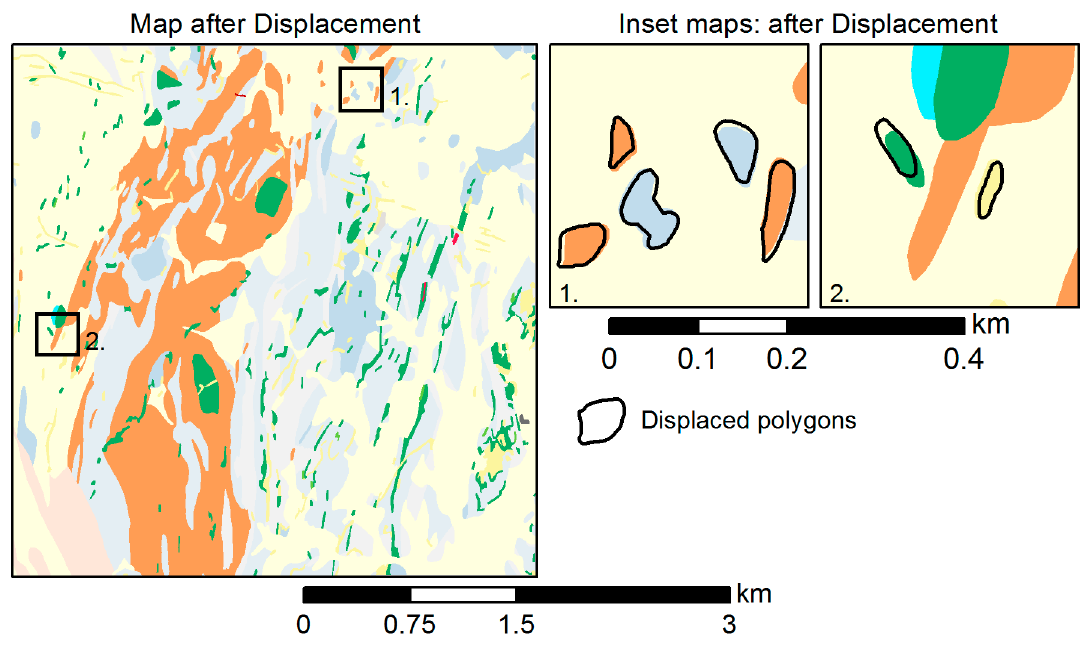
Figure 13. The generalized map after displacement. To the right, two detailed examples illustrating displaced polygons are shown.